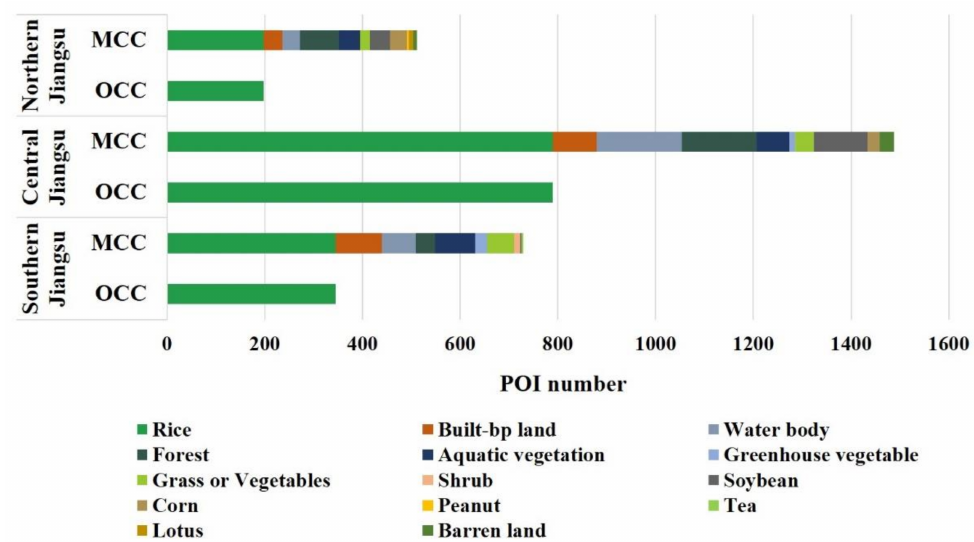
Figure 10. Comparison of training samples used by MCC and OCC methods. The training samples were counted as the number of polygons of interest defined for the classifiers. MCC stands for MCSVC and DTC and OCC stands for VIT and OCSVC.